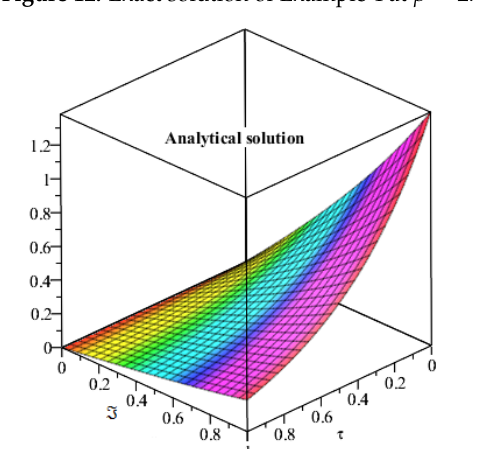
Figure 13. analytical solution of Example 4 at β = 2.